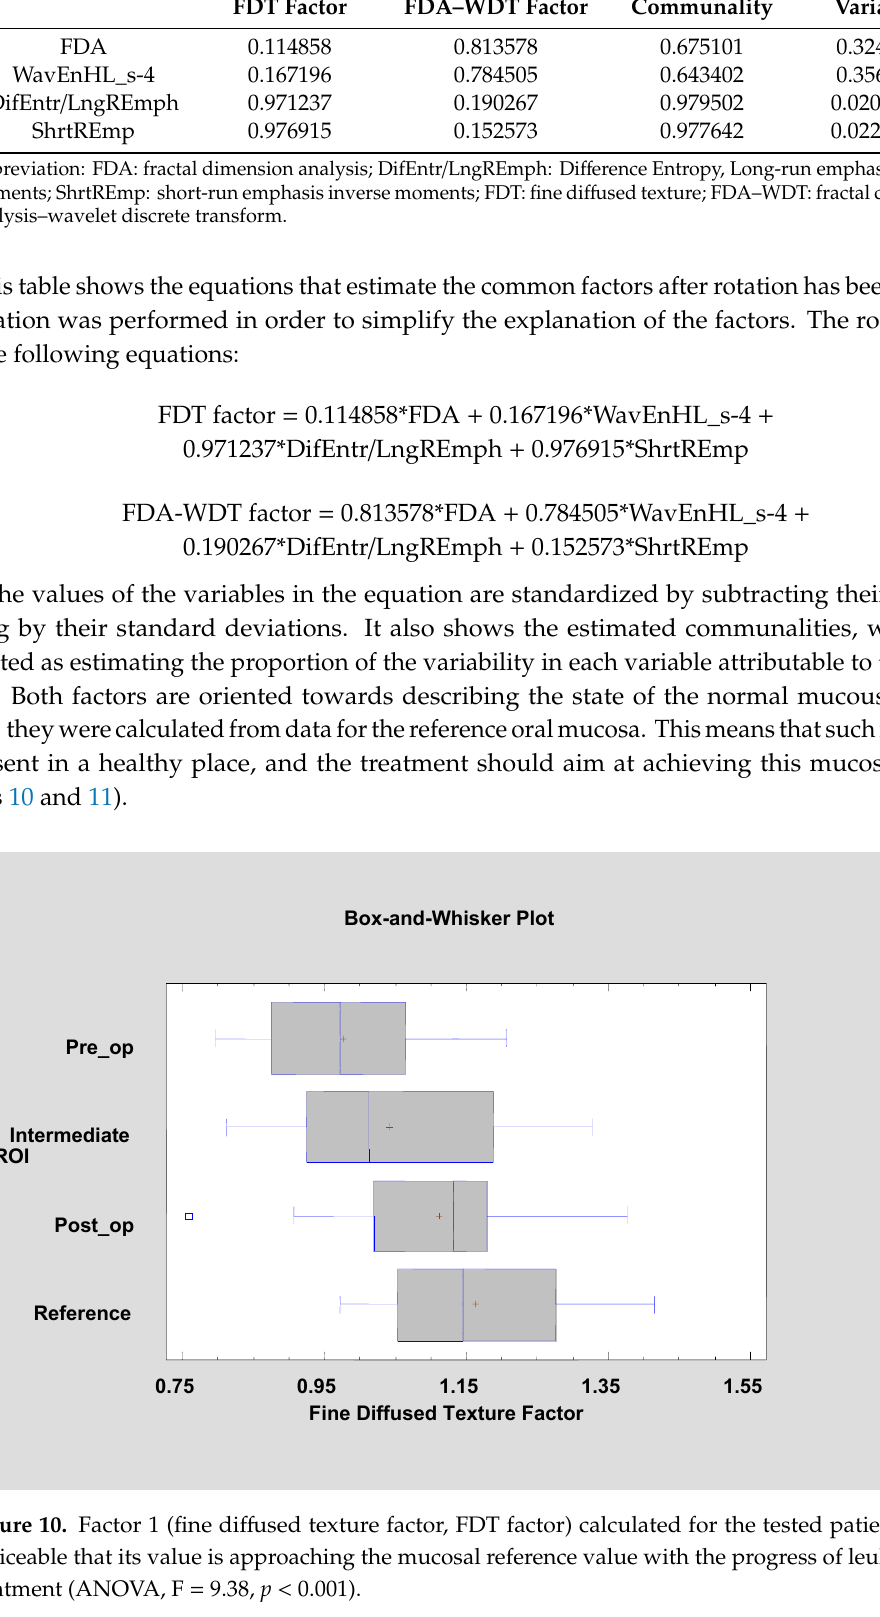
Table 4. Factor loading matrix after varimax rotation.